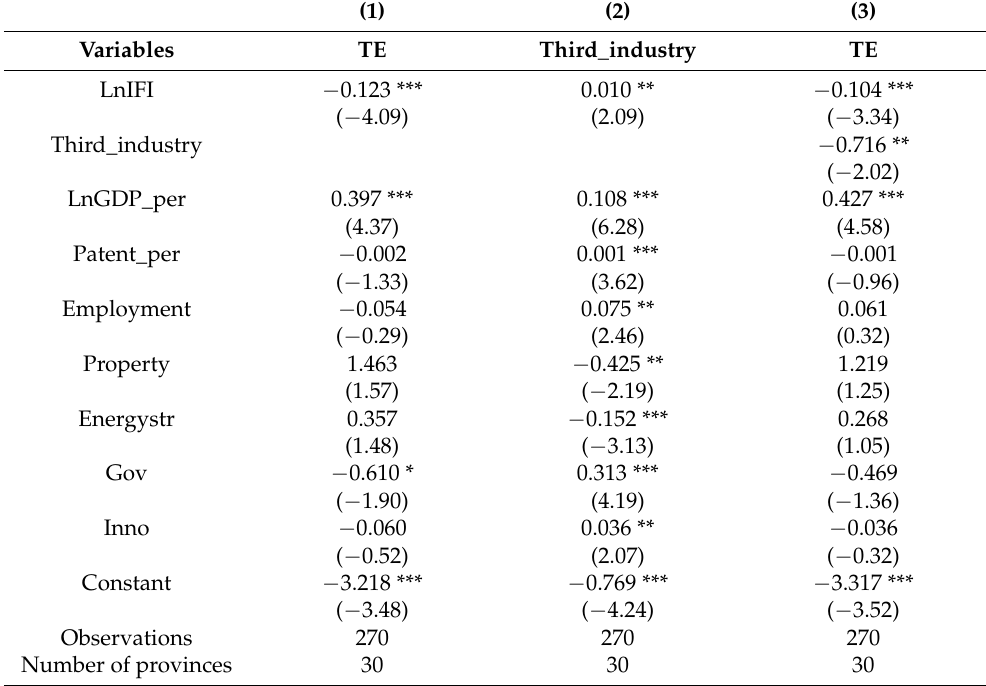
Table 7. Mediation effect.